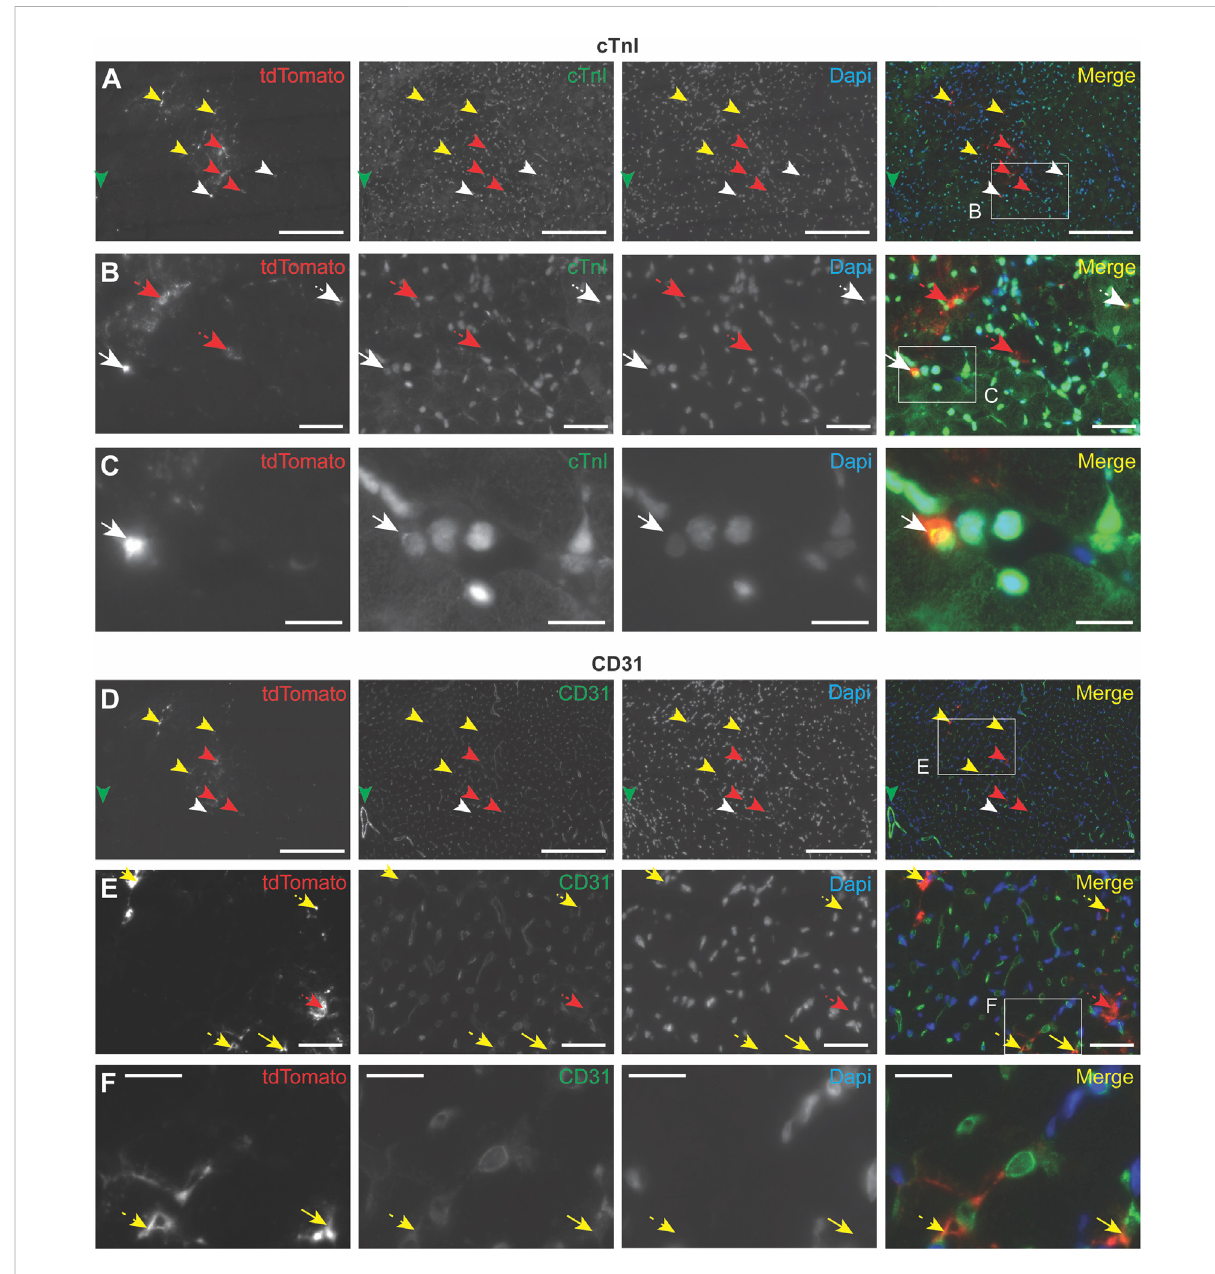
FIGURE 4 Immunocytochemistry analysis of EV uptake in the heart. PalmtdTomato-EVs were administered in the left ventricle wall of a healthy mouse heart through intramyocardial injection and heart tissue was collected after 4 h (A – F) Immuno fl uorescence staining of two subsequent heart sections, cut across the sagittal plane, using antibodies against tdTomato (shown in red), and co-staining with antibodies against (A – C) cardiomyocytemarkercardiacTroponinI(cTnI,showningreen)and (D – F) bloodvessel-speci fi cCD31(showningreen). (B) Enlargementofthe square inpanel A. (C) Enlargement ofthesquare inpanel B. (E) Enlargementofthesquare inpanel D. (F) Enlargement ofthesquare inpanel E. Nuclei arevisualized withDAPI(showninblue).tdTomatoco-localizationwith otherstainingsareindicatedwitharrows: cTnI(white),CD31 (yellow),noco- localization (red). Scale bars = 50 μ m (A,D) , 250 μ m (B,E) , 100 μ m (C,F)